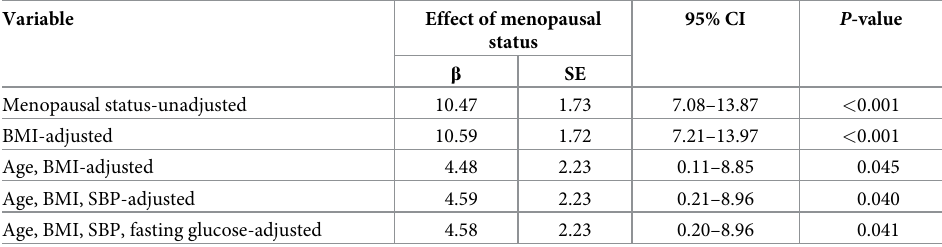
Table 4. Association of menopausal status with total cholesterol by multiple linear regression analyses.